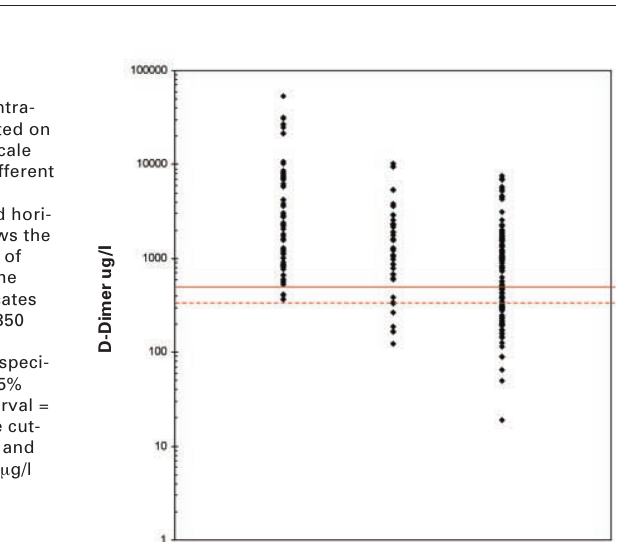
b. Overview of the diagnostic result of the patients with sus- pected DVT analysed with CUS/phlebogra- phy and D-dimer.